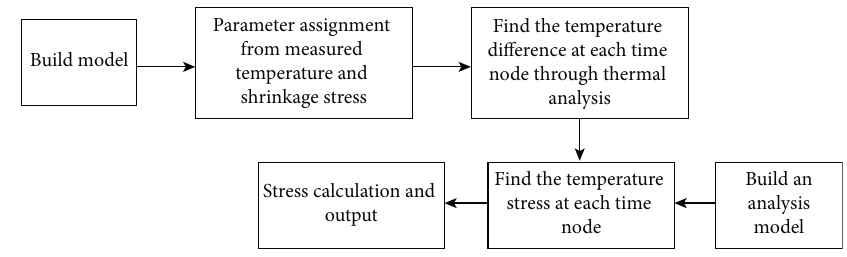
Figure 1: The fi nite element analysis process.